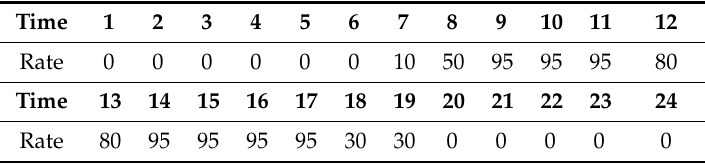
Table 9. Calculation time (h) and lighting hourly rate